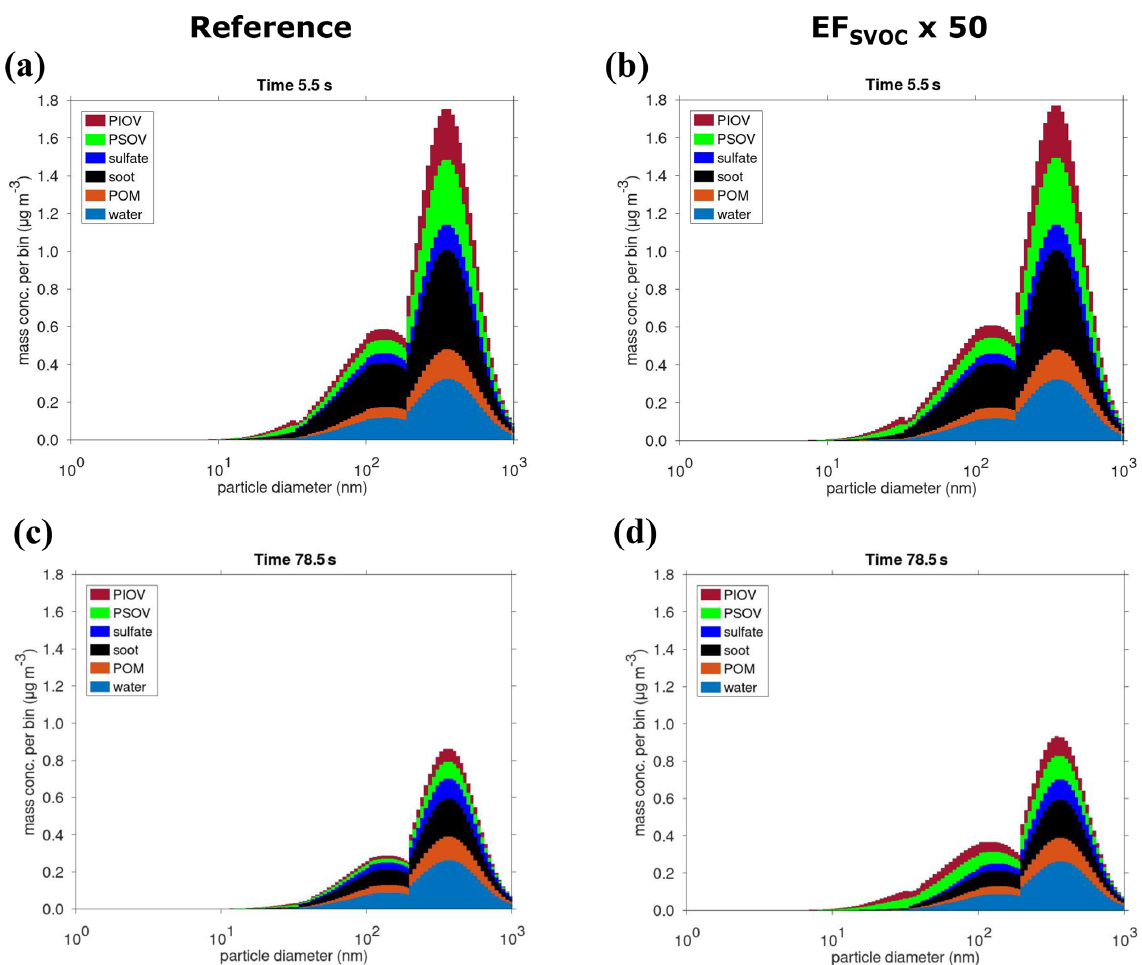
Figure 14. Aerosol chemical composition obtained from the MAFOR model, given as mass concentration per size bin, in the Urban Case scenario: (a) reference simulation at point A; (b) simulation EF SVOC × 50 at point A; (c) reference simulation at point D; and (d) simulation EF SVOC × 50 at point